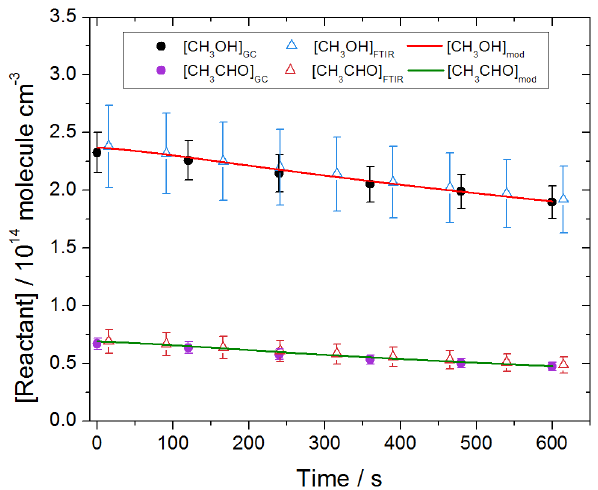
Figure 1. Decay of reactants CH 3 CHO and CH 3 OH from ex- periment P11 measured simultaneously using FTIR and GC- FID conducted at 1000mbar and 298K. Error bars are rep- resentative of the uncertainty in the calibration of the FTIR and GC-FID ( ± 2 σ) . Measurements are in excellent agree- ment within their respective uncertainties. Chemical simula- tion was conducted using the reaction scheme outlined in Table 2 using k (R5) = 2 . 35 × 10 − 11 cm 3 molecule − 1 s − 1